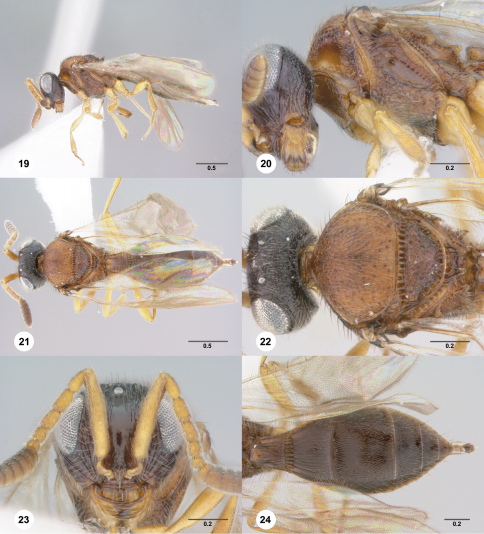
65Paridris atrox sp. n., female holotype (OSUC 241473) 19 Lateral habitus20 Head and mesosoma, lateral view21 Dorsal habitus22 Head and mesosoma, dorsal view23 Head, anterior view24 Metasoma, dorsal view. Scale bars in millimeters.